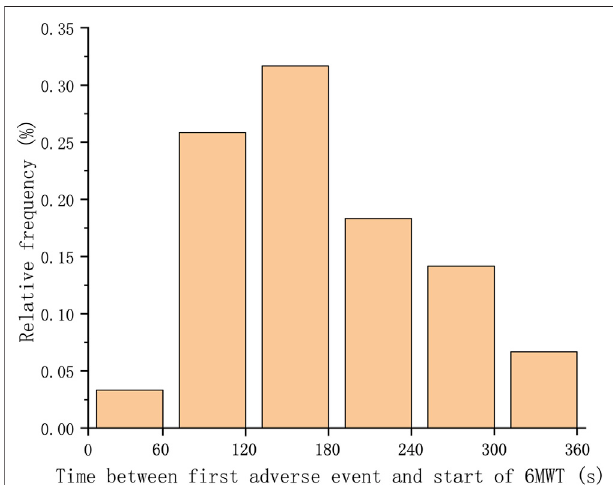
FIGURE 2 | Distribution of the time between the occurrence of the fi rst adverseeventandthebeginningofthe6MWT.Adverseeventsofover95%of patients occurred after 1